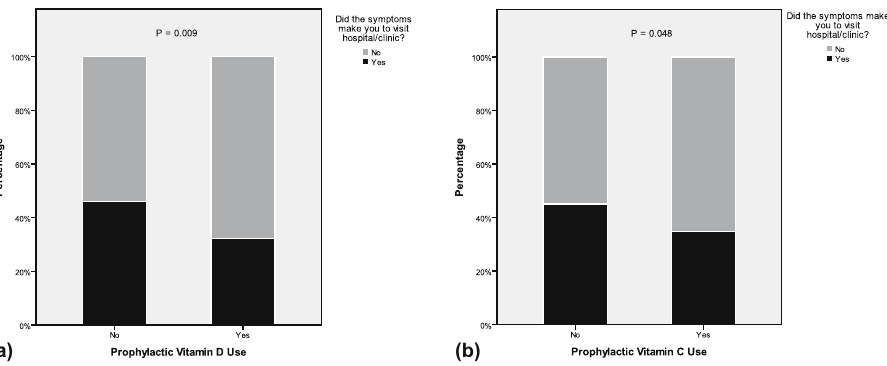
Figure 6: The proportion of hospital visit in patients with or without the use of prophylactic vitamin D ( a ) and vitamin C ( b )